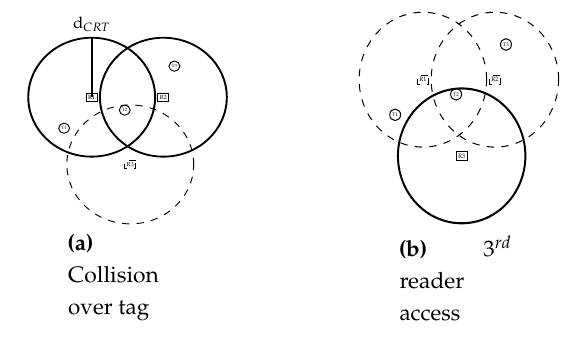
Figure 6. Collision